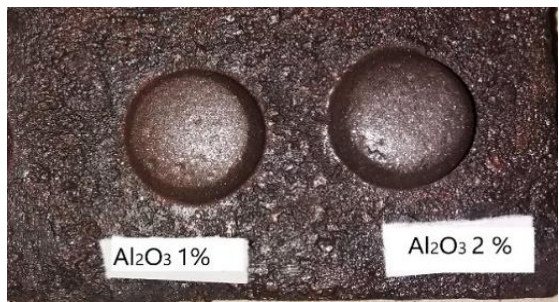
Figure 5. Peridotite sample E6382 with the Al 2 O 3 addition after calcination.